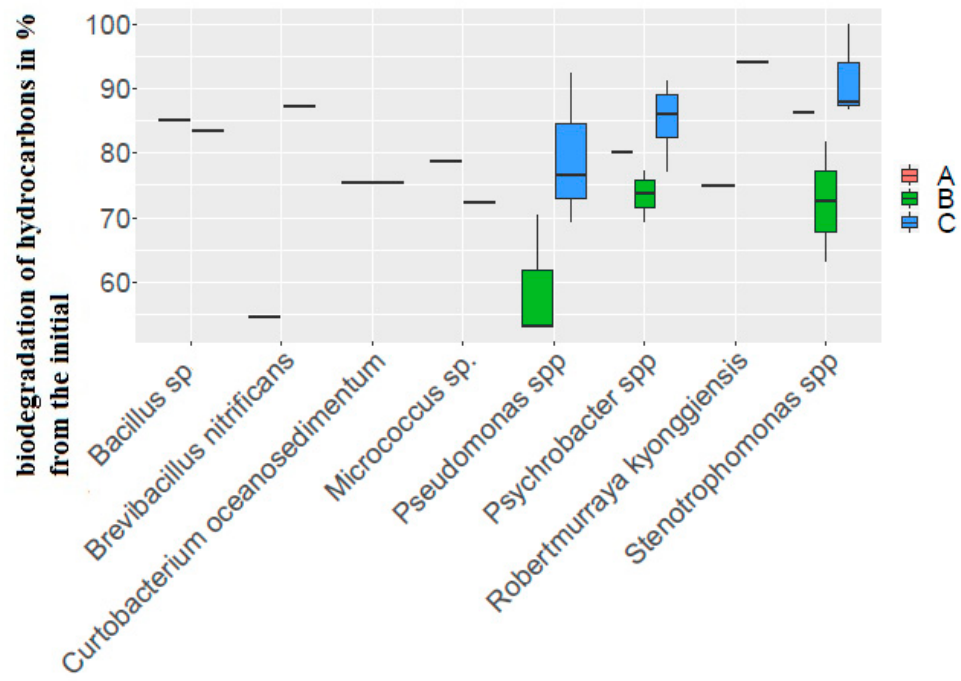
Figure 6. Biodegradation of hydrocarbons by strains isolated from the non-gas-hydrate region. (A) The degree of biodegradation of oil by strains capable of utilizing oil only under aerobic conditions; (B) the degree of oil biodegradation by strains capable of utilizing oil both under aerobic and anaerobic conditions (aerobic conditions); (C) the degree of oil biodegradation by strains capable of utilizing oil both under aerobic and anaerobic conditions (anaerobic conditions). The corresponding data can be found in Table S3.